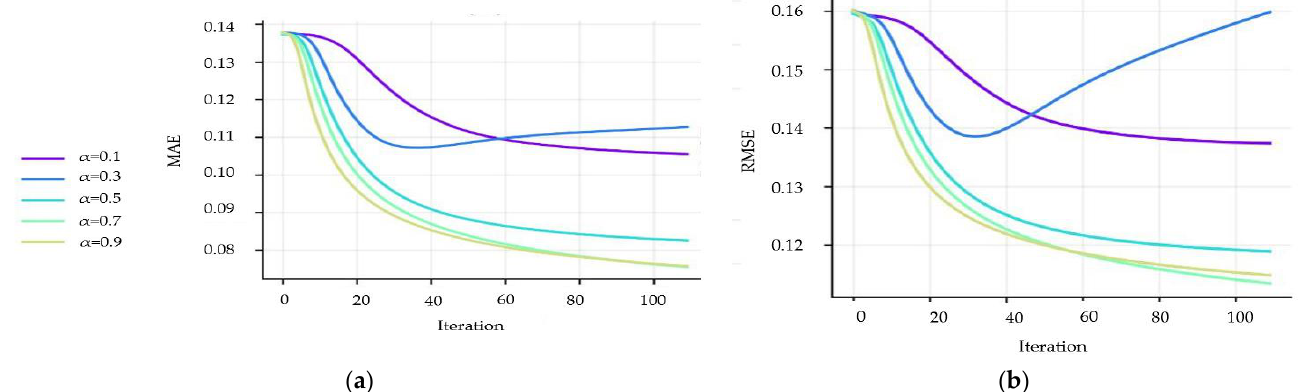
Figure 4. Impact of α on MAE ( a ) and RMSE ( b ).